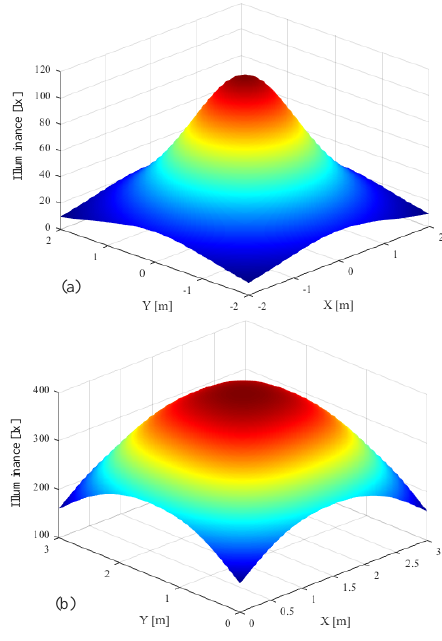
Figure A2. Luminance level in ( a ) an area equipped with a single transmitter with a unity optical power; ( b ) a room with four luminaires when each luminaire is transmitting 1.57 W of optical